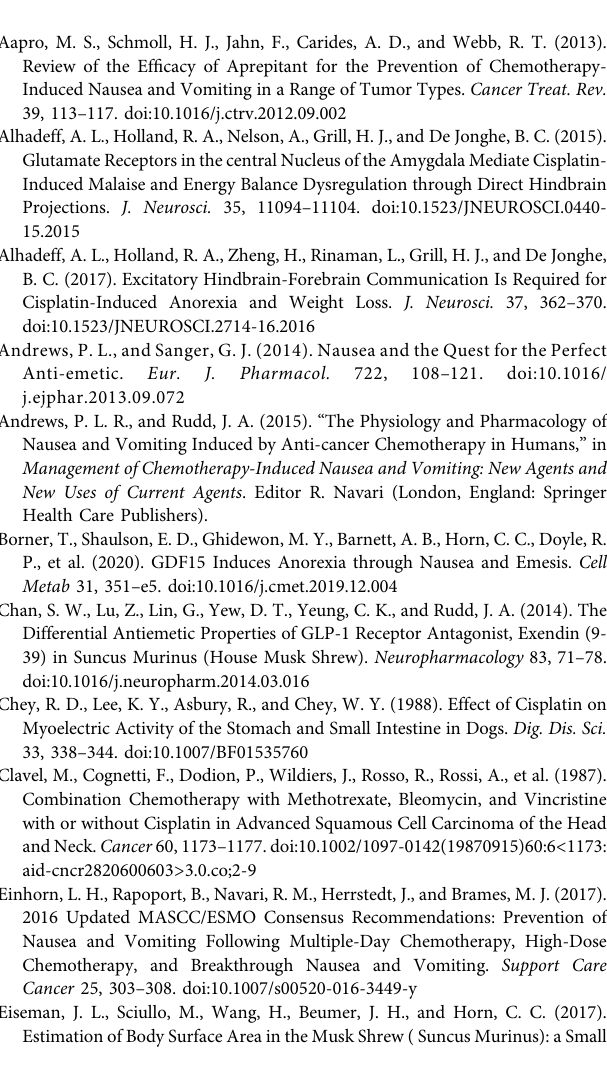
Supplementary Figure 2 | The pro fi le of cisplatin- and vehicle-induced retching + vomiting in Suncus murinus during a72-hobservation period. Results areplottedas means ± standard errors of the mean for n (cid:1) 7 animals. Supplementary Figure 3 | Multifractal detrended fl uctuation analysis of gastric myoelectric activity (GMA) in Suncus murinus . (A) Generalised Hurst exponent h(q) vs. order q, and (B) dimension of subset series f( α ) vs. singularity strength α for GMA in one animal during four different time-periods: pre-cisplatin treatment (-24 – 0 h) and post-cisplatin treatment (0 – 24 h, 24 – 48 h and 48 – 72 h); (C) the width of the multifractal spectrum ( Δα ) in four different periods (-24 – 0 h, 0 – 24 h, 24 – 48 h and 48 – 72 h) in the vehicle and cisplatin groups are shown, and data are means ± standard errors of the mean for n (cid:1) 7 – 8 animals. No signi fi cant differences were found between the saline and cisplatin groups [one-way analysis of variance (ANOVA) or two-way ANOVA, as appropriate]. Supplementary Figure 4 | Dominant frequency (A) and repartition of gastric myoelectric activity in the bradygastric (B) , normogastric (C) and tachygastric (D) ranges during baseline, immediately before emetic episodes, during emetic episodes and immediately after emetic episodes induced by cisplatin (30 mg/kg, i.p.) in Suncus murinus (seeMethod2.7.2,formethodology).Resultsareshownasmeans ± standard errors of the mean for n (cid:1) 7 animals. Signi fi cant differences compared to baseline are shown as **p < 0.0 or *p < 0.05 (one-way ANOVA followed by Bonferroni